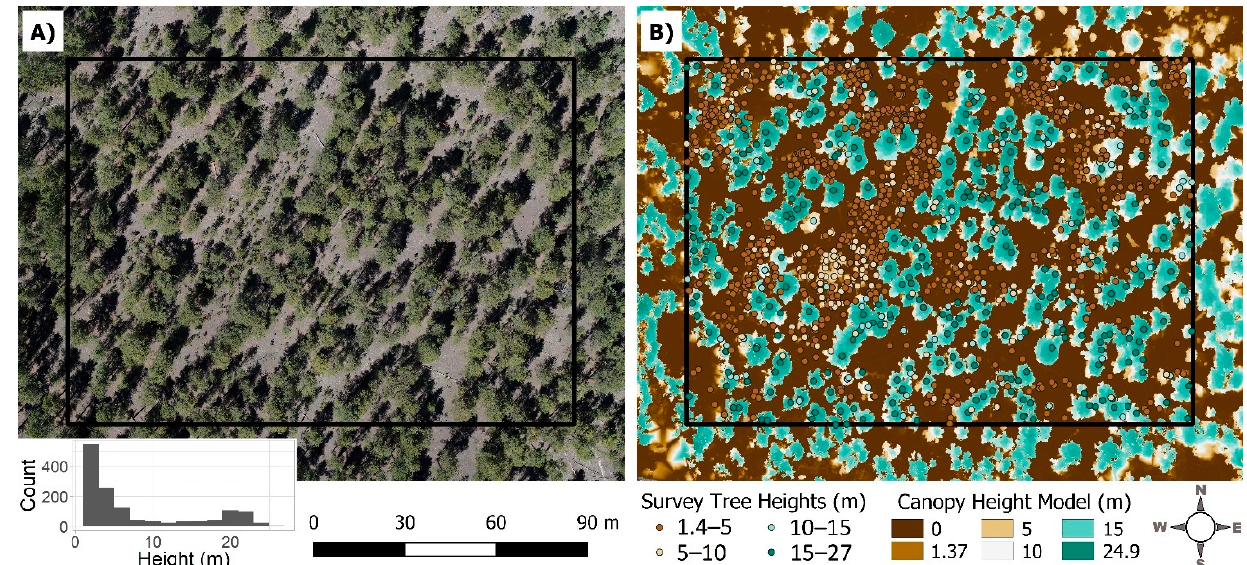
Figure 1. Study area portrayed with ( A ) unmanned aerial system (UAS) orthophoto at 2.6 cm resolution with inset distribution of survey tree heights and ( B ) UAS-derived Canopy Height Model at 10 cm resolution from High Quality and Mild depth map filtering with overlaid survey trees colored by height to demonstrate data alignment.